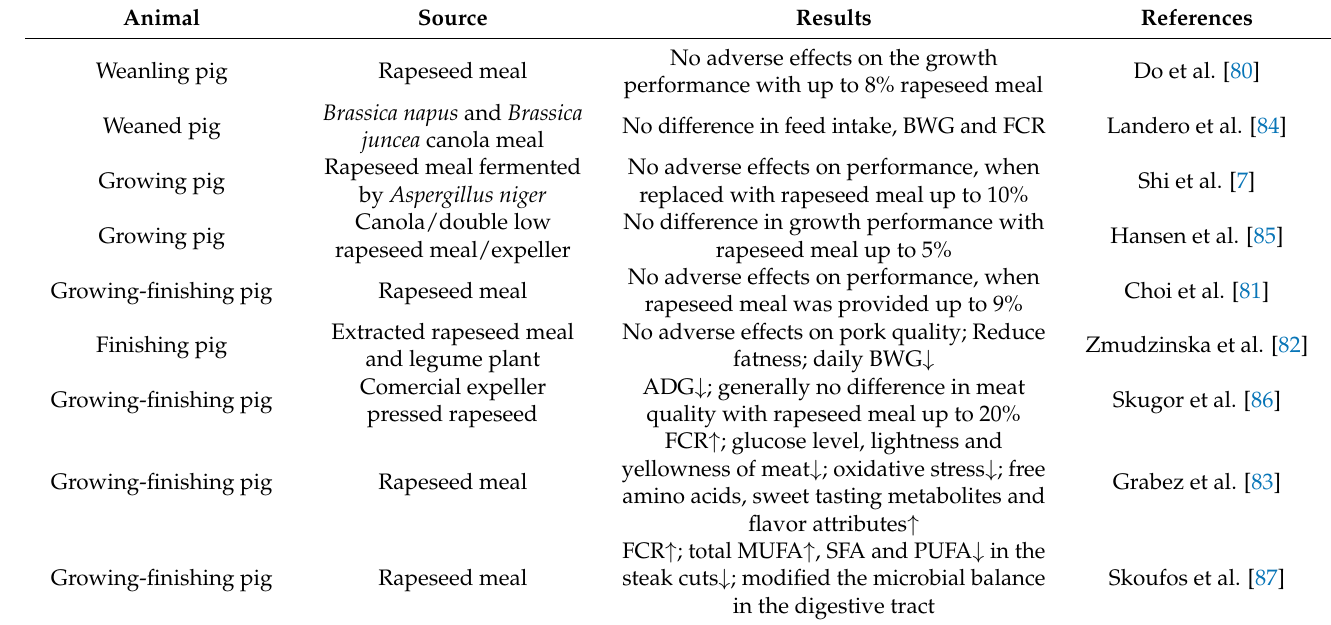
Table 4. The effects of rapeseed meal on growth performance and meat quality of